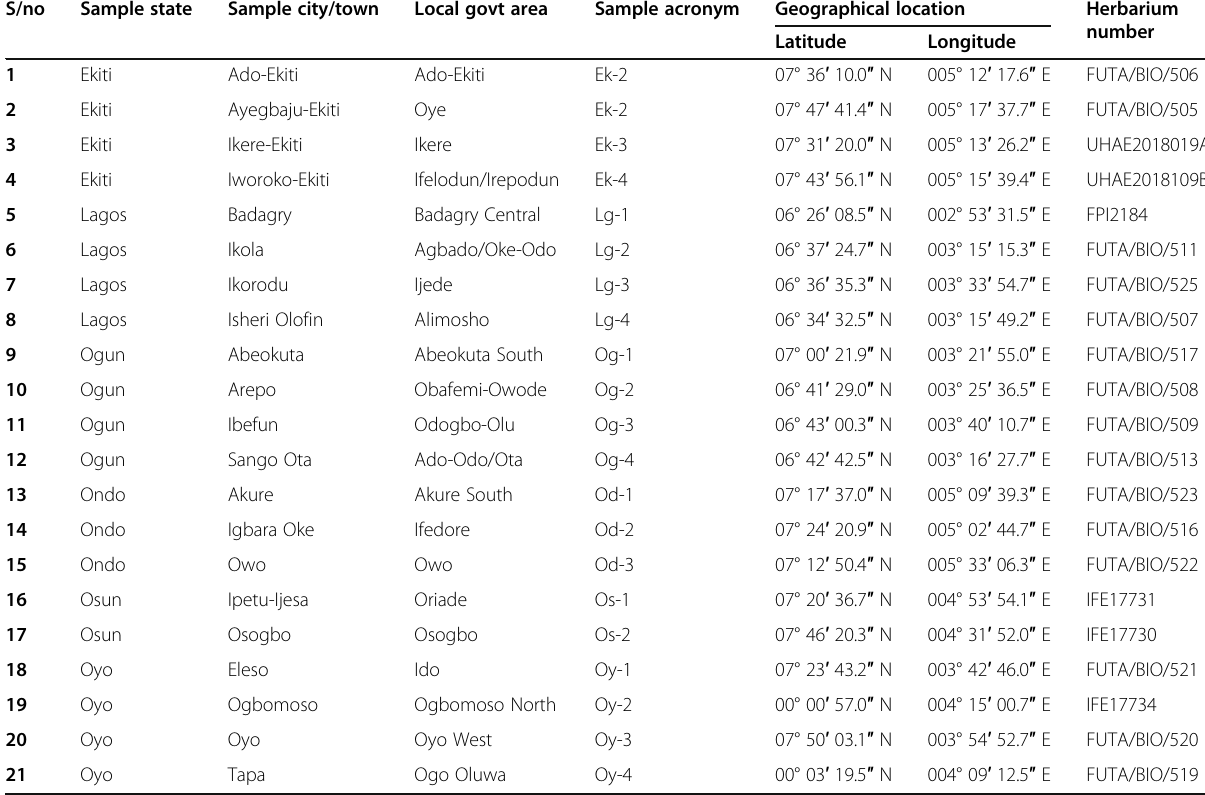
Table 1 The table showing the details of the samples collected from the 6 different states in Nigeria